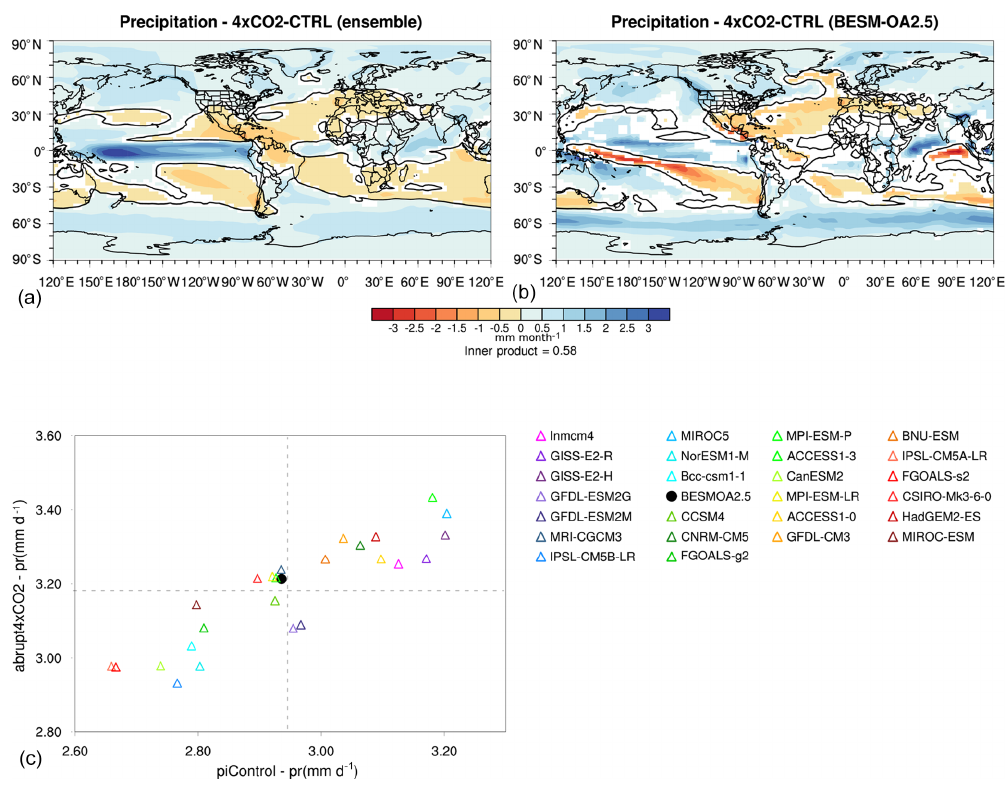
Figure 9. Differences (averaged over years 120–150) in precipitation (mmmonth − 1 ) between the abrupt4xCO2 and piControl simulations in (a) the CMIP5 ensemble and (b) BESM-OA2.5. (c) A scatter plot of the precipitation global averages for the CMIP5 models used in the ensemble and BESM-OA2.5 (black dot). The shaded areas in (a) and (b) have confidence levels greater than 90%; the black line represents the contour line of zero precipitation difference.